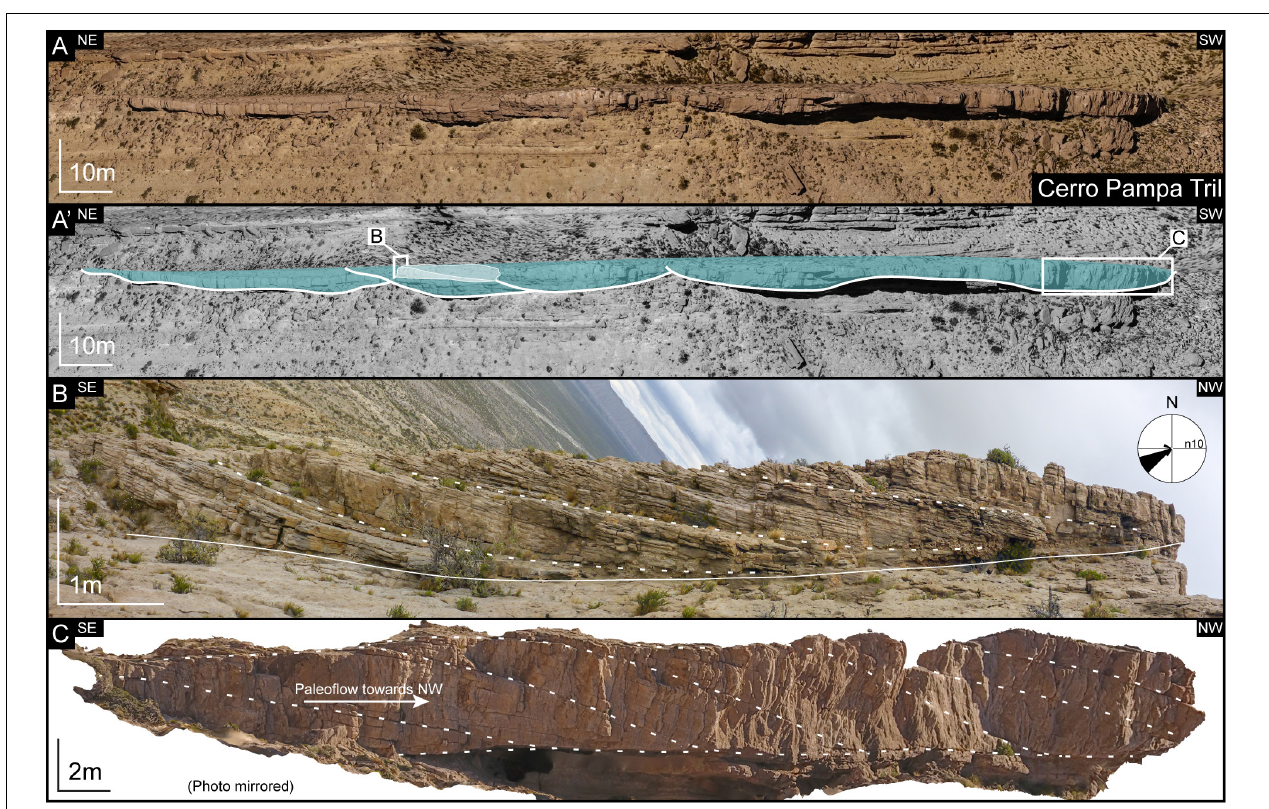
FIGURE 8 | Overview of FA5—ooid bars or dunes deposits at Cerro Pampa Tril ( Figure 1D ), figure location indicated in Figure 9 . (A) Orthorectified overview photograph looking into structural dip. (A’) Overlay interpretation of outcrop photo, blue indicates FA5 extent, and white fill indicates the 3D dune in sub-figure B . (B) Panorama picture from 3D dune in upper FA5; white dotted lines indicate tangential cross-strata with transport direction southwestward. Paleocurrent data included; note that the apparent dip toward NW in the picture is due to curved cross-sets. (C) Orthorectified photograph of sigmoidal foresets, indicated by white dotted lines, paleoflow toward northwest; note: